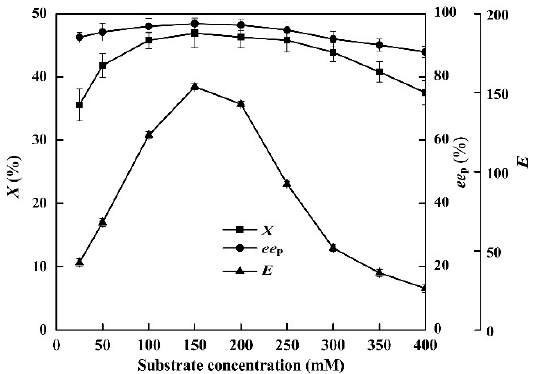
Figure 5. Effect of ibuprofen ethyl ester concentration on the conversion degree, enantiomeric excess of product and enantioselectivity of EST10 using [OmPy][BF 4 ] as a co-solvent in the presence of enzyme EST10 (15 mg/mL) at 75 °C for 10 h. The values are means of three independent experiments.